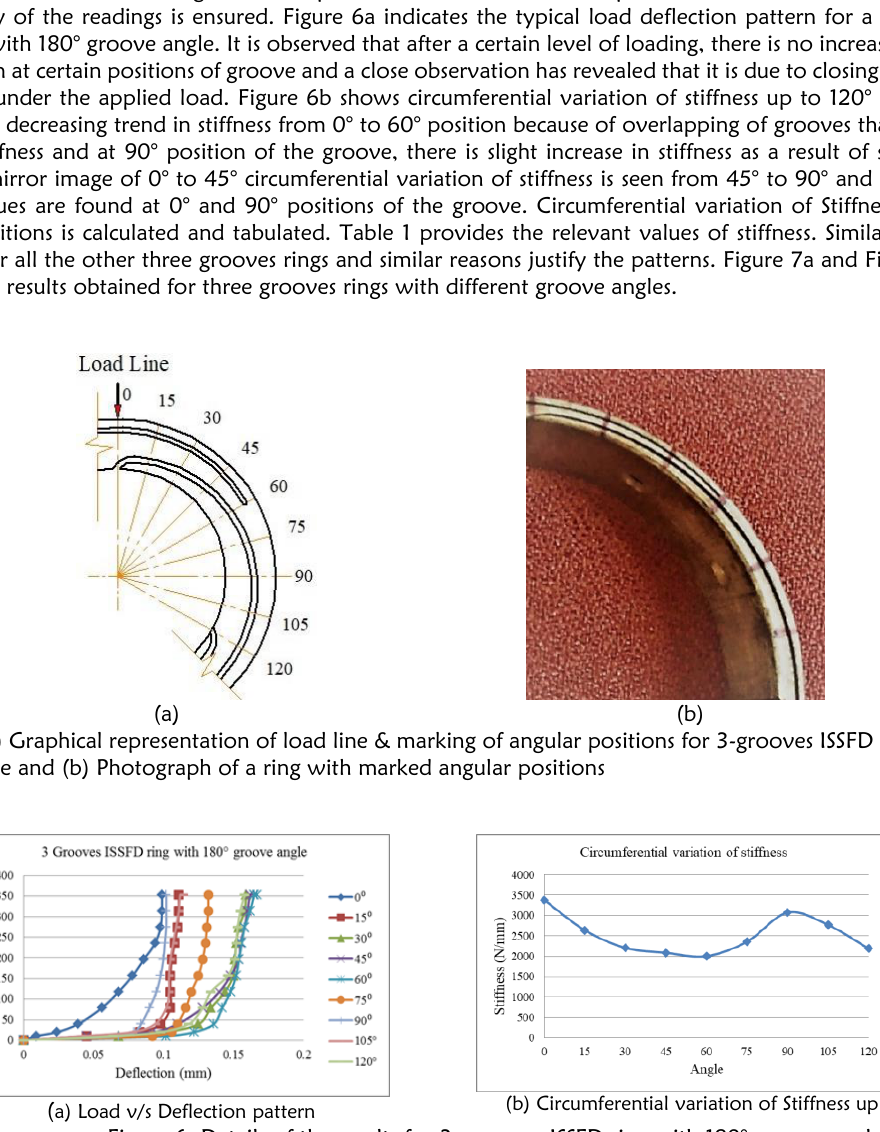
Figure 6: Details of the results for 3- grooves ISSFD ring with 180° groove